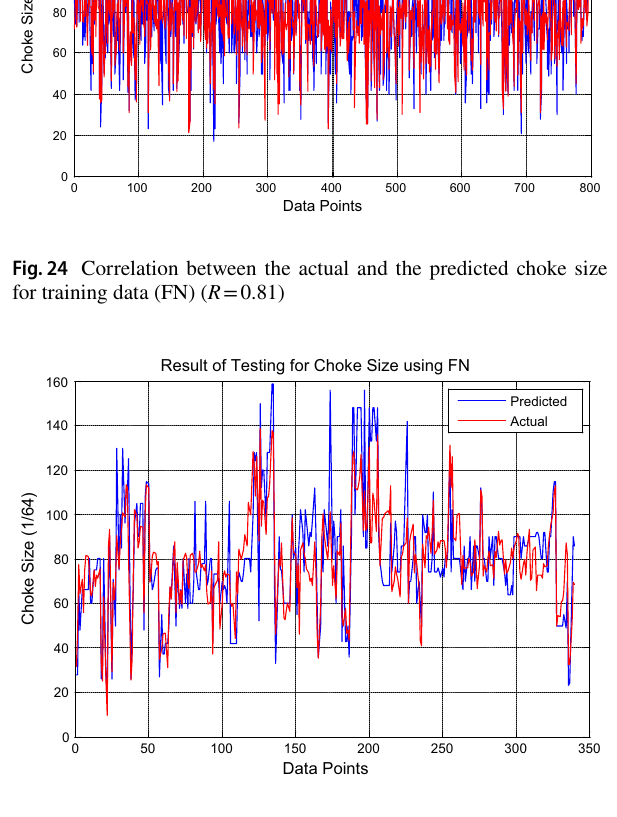
Fig. 23 Correlation between the actual and the predicted choke size for testing data (Gaussian function) ( R = 0.998) Table 10 Correlation coefficient for trained and tested data of SVM model